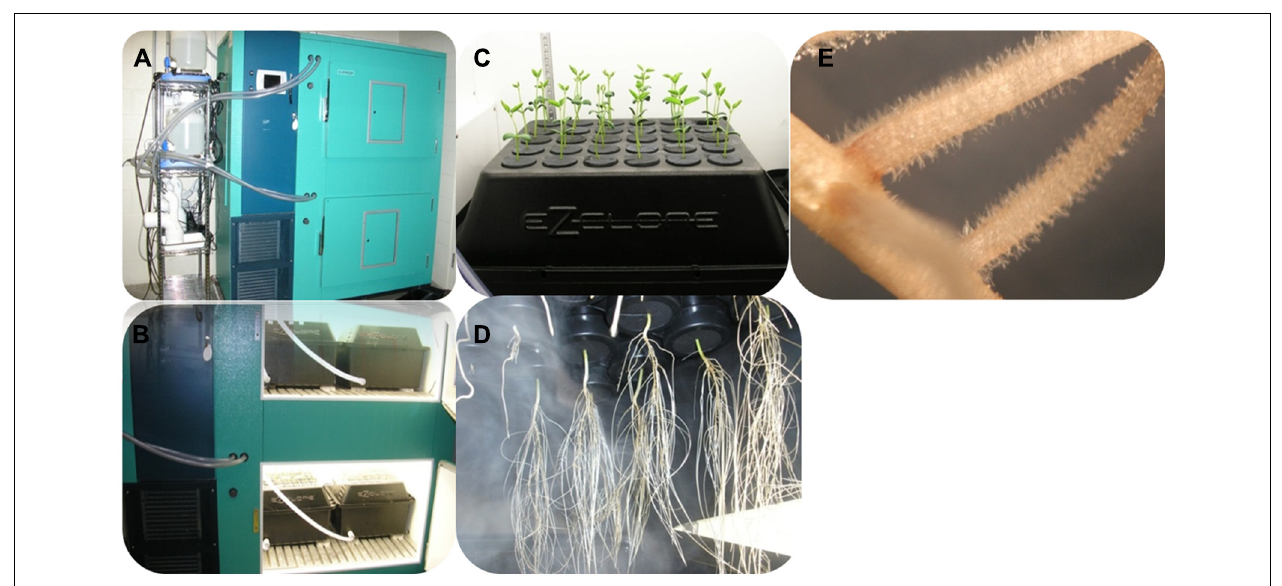
FIGURE 2 | Soybean seedlings grown in the ultrasound aeroponic system; (A,B) the whole system for plant culturing; (C,D) the plants in the EZ-cloner; (E) soybean root showing a high density in root hair